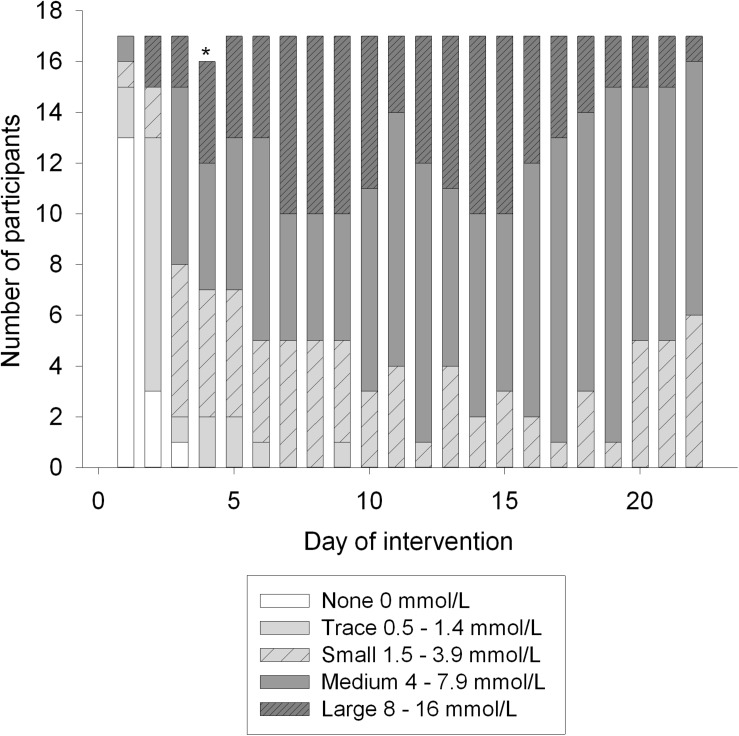
Ketone bodies in urine during the intervention, measured with semi-quantitative method (Ketostix). Amount of ketones evaluated by strip-color divides participants into five groups; none, trace, small, medium and large. ∗Indicates a missing value.